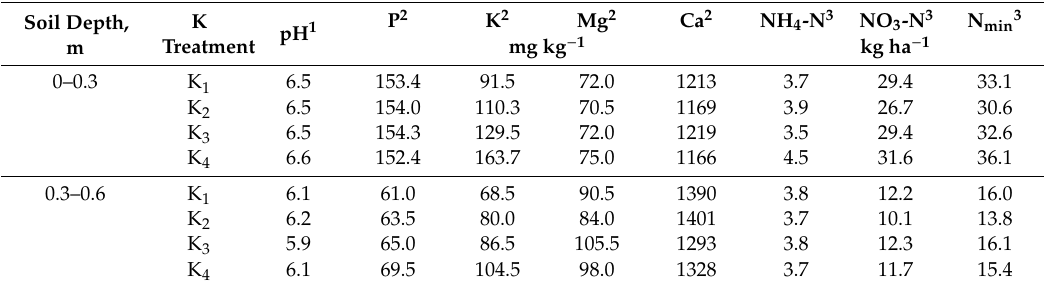
Table 1. Soil chemical properties as a result of stationary long-term field experiments, varied K fertilization (mean for three years).